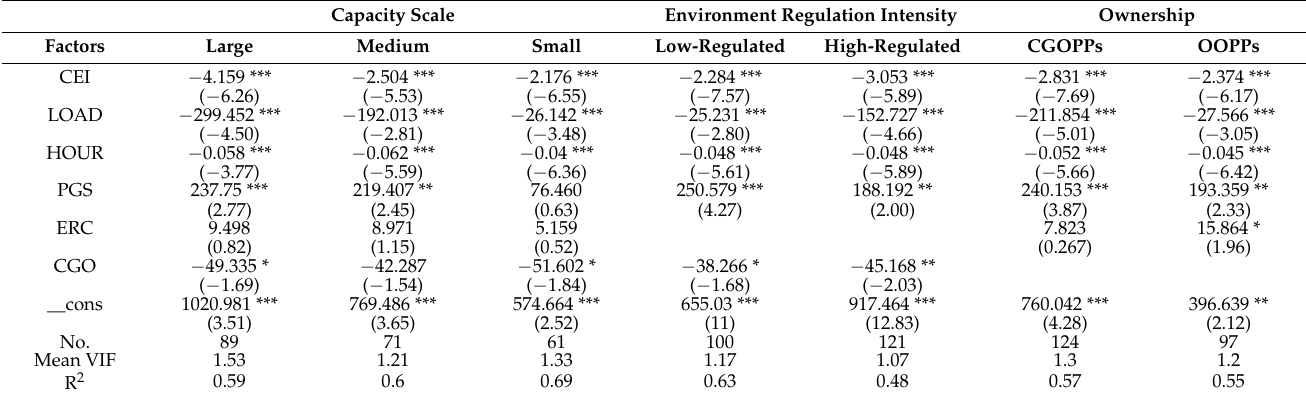
Table 5. Heterogeneity analysis of influencing factors on MACs of CO 2